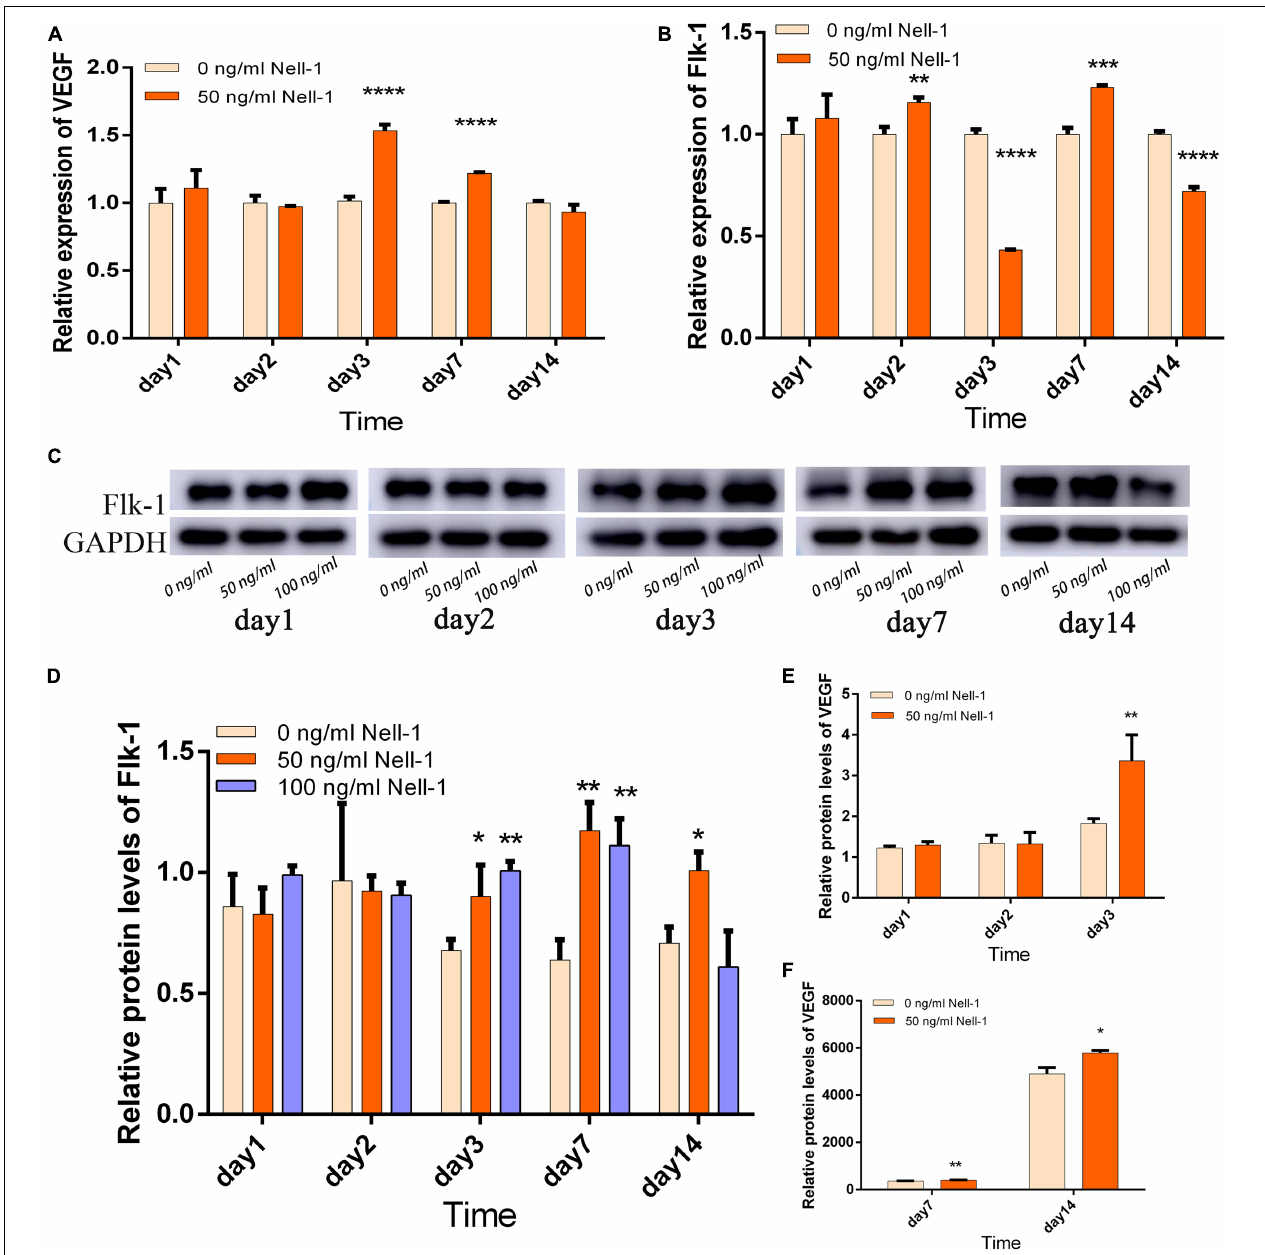
FIGURE 3 | Angiogenesis-related gene and protein expression in the co-culture group. (A) VEGF gene expression was improved by 50 ng/mL Nell-1 treatment in days 3 and 7. (B) Flk-1 gene expression was improved by 50 ng/mL Nell-1 treatment in days 2 and 7, but was decreased in day 3 and 14. (C,D) Flk-1 protein expression was increased by 50 and 100 ng/mL Nell-1 treatment in days 3, 7, and 14. (E,F) VEGF protein expression was increased by 50 ng/mL Nell-1 treatment in days 3, 7, and 14. Data are shown as the mean ± SD. (* p < 0.05, ** p < 0.01, *** p < 0.001, **** p <